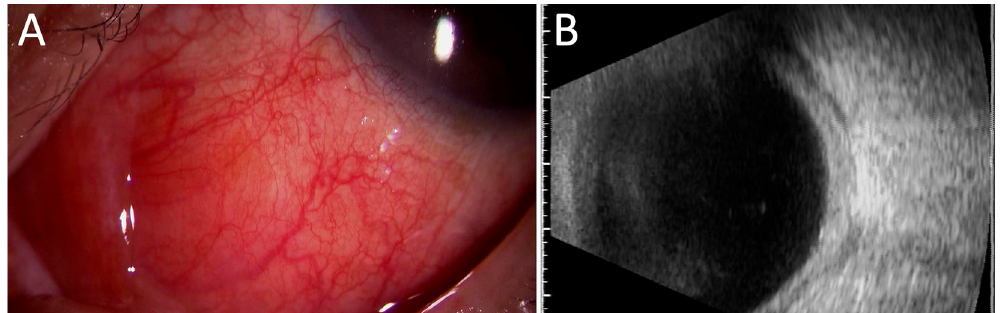
Figure 2. Nodular anterior and posterior scleritis associated with RPC: slit-lamp exam showed anterior nodular scleritis ( A ) and B-scan ultrasonogram ( B ) showed thickened sclera with fluid in the sub-Tenon’s space (T-sign). Table 4. Types of scleritis in previous case series.